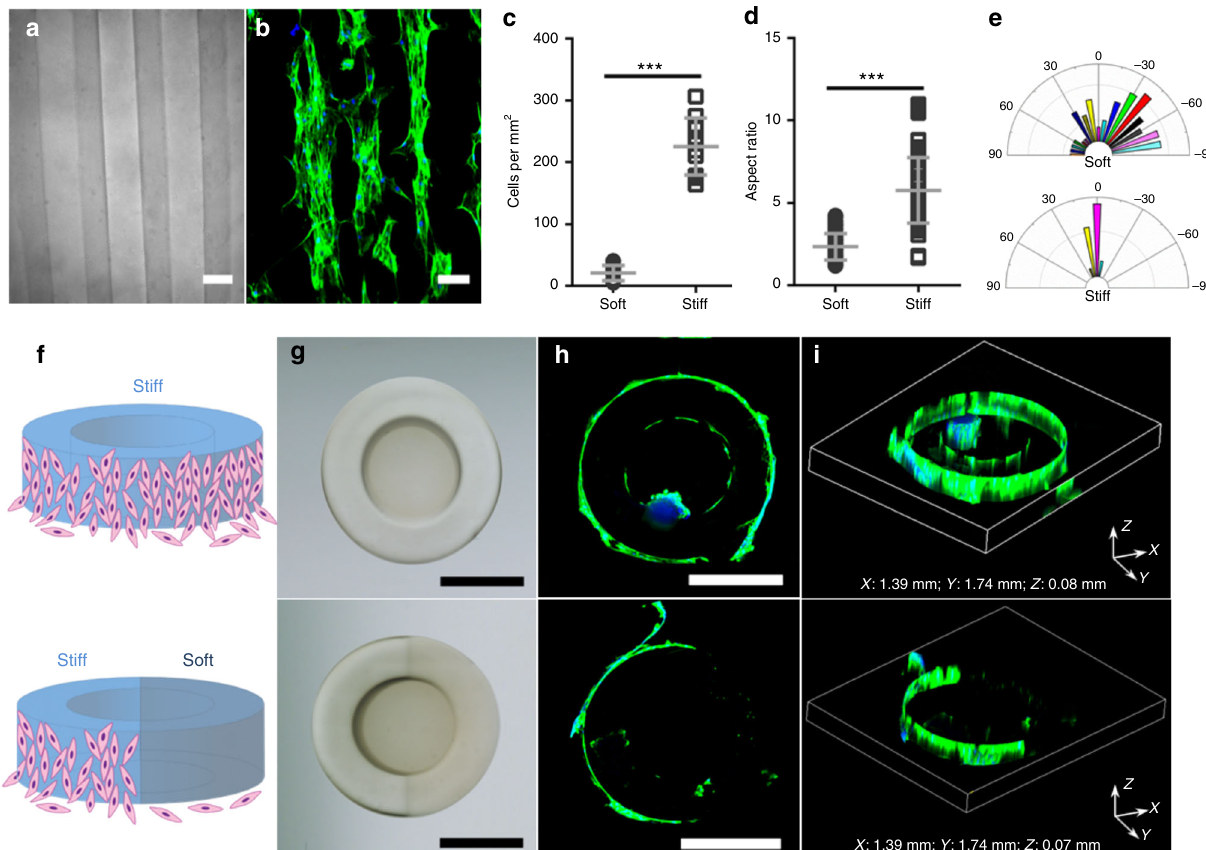
Fig. 4 Spatial control of cellular organization on structures with independently programmed stiffness and geometry. a Bright- fi eld optical image of an alternating 2D soft/stiff stripe patterns (dark line: soft, crosslinked at 44 mJ cm − 2 with E ~ 5 kPa; bright line: stiff, crosslinked at 72 mJ cm − 2 with E ~ 11 kPa; line width: 100 μ m). b bPASMCs cultured on stiffness-patterned structures prefer to attach to stiff regions vs. soft regions. Quanti fi cation of number of cells per mm 2 ( c ), aspect ratio ( d ), and alignment (0 degree being perfectly aligned to the pattern) ( e ) showed the majority of cells attached to stiff regions and those cells were more elongated and aligned along the direction of patterned stiffness strips compared to the limited number of cells attached to soft regions. f The preferential cell attachment to 2D stiff strip patterns motivates further investigation of 3D cellular organizations. Our hypothesis of directed 3D cell migration by patterned stiffness pro fi les in printed vascular-tube-like structures. g Bright- fi eld microscope images of printed tube structures with either uniformly stiff (upper panel) or soft-stiff (half-half; lower panel) walls. The patterned stiffness is expected to be E ~ 11 kPa for stiff walls and E ~ 5 kPa for soft walls. The printed tube structures have an outer diameter of 1 mm, an inner diameter of 0.6 mm, and height of 0.1 mm. Confocal X-Y projection ( h ) and 3D view ( i ) showed bPASMCs cultured on printed tube structures preferred to migrate up stiff walls vs. soft walls over the course of the 3-day culture, producing a either 3D whole or half vascular-tube-like tissue structure. Green: f-actin. Blue: nuclei. Scale bars are: a , b 100 μ m; g , h 500 μ m. Error bars represent standard deviation (s.d.); n = 10 random images for counting cell number per mm 2 , and n > 90 cells for calculating aspect ratio and alignment. *** p <